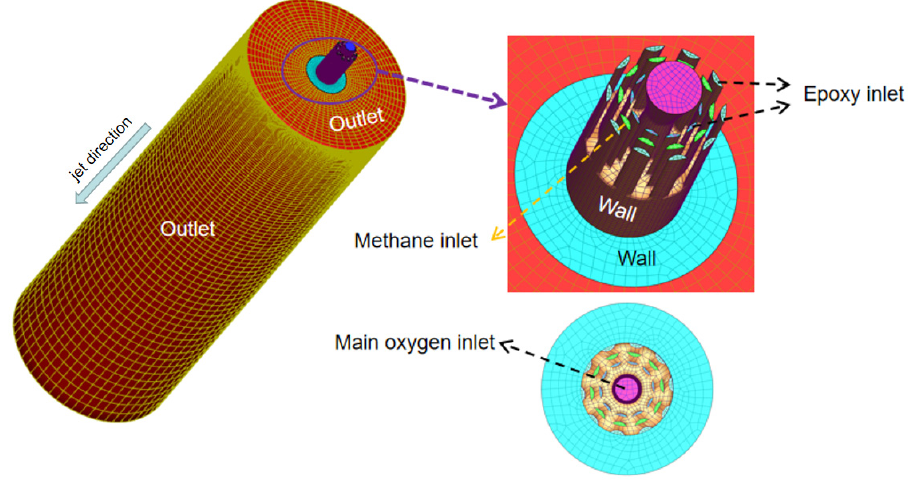
Figure 4. Schematic diagram of the coherent supersonic jet nozzle. Table 1. Boundary conditions.